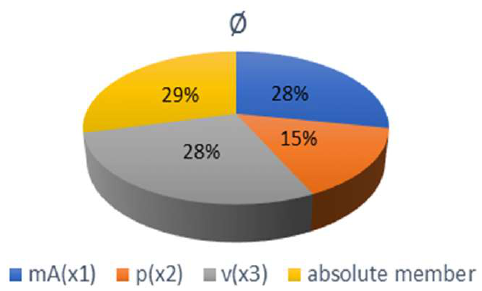
Figure 14. Graph of significance of mathematical model parameters for deflection Ø .